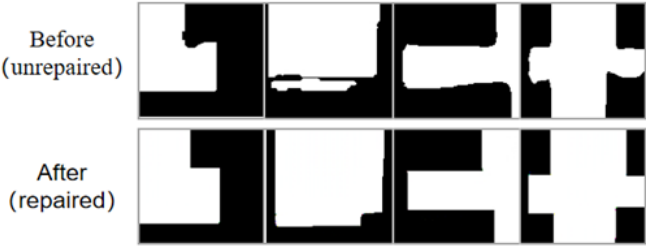
Figure 2. Comparison of unrepaired masks with repaired masks.